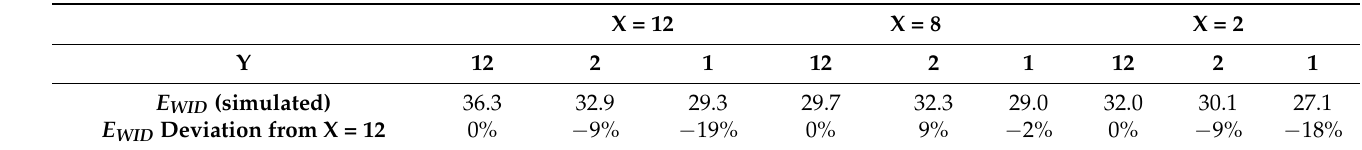
Table 4. An example of simulated background luminance for different room widths while the length also is changing. X = 12 X =